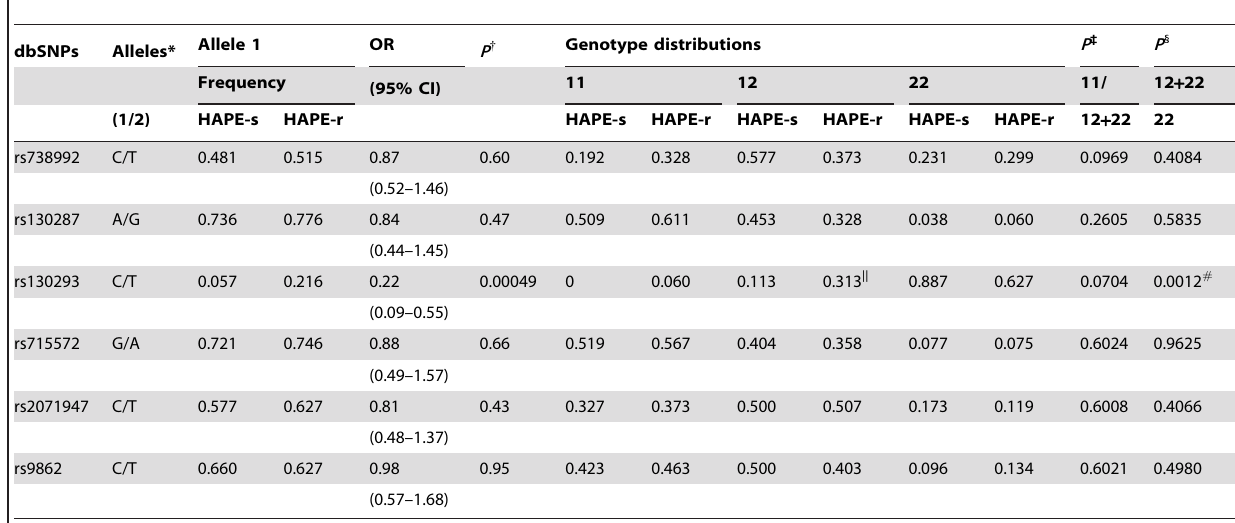
Table 3. The allele frequencies and genotype distributions of the six SNPs of the TIMP3 gene in HAPE-s and HAPE-r subjects.